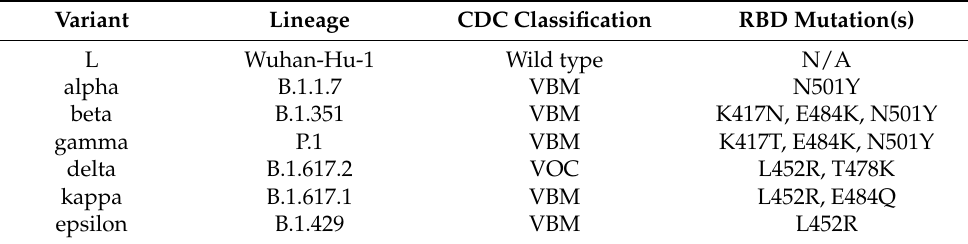
Table 1. Major circulating SARS-CoV-2 variants and their RBD mutations.